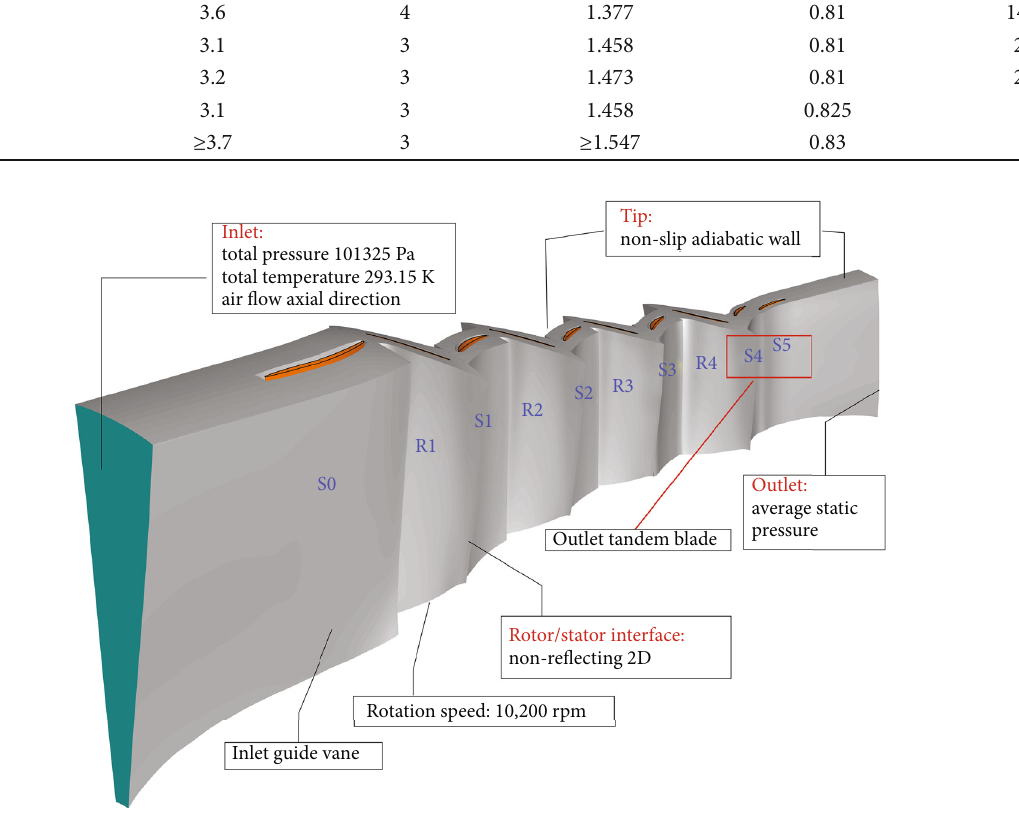
Figure 8: Calculation domain and boundary condition setting for four-stage low-pressure Figure 7. The inlet is a guide vane, and the outlet is tandem.